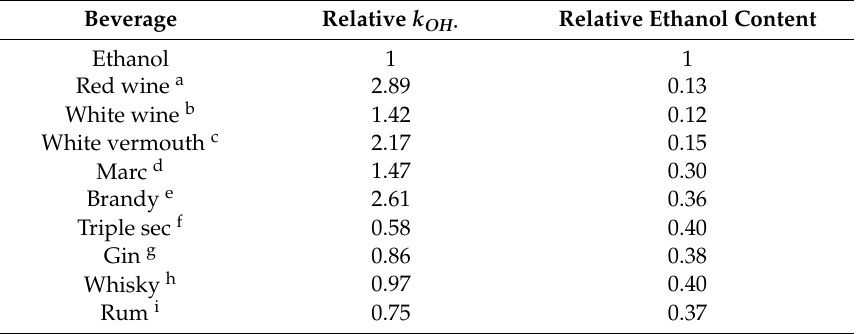
Table 1. Quenching rate constants for the beverages against the hydroxyl radical ( • OH) relative to ethanol.